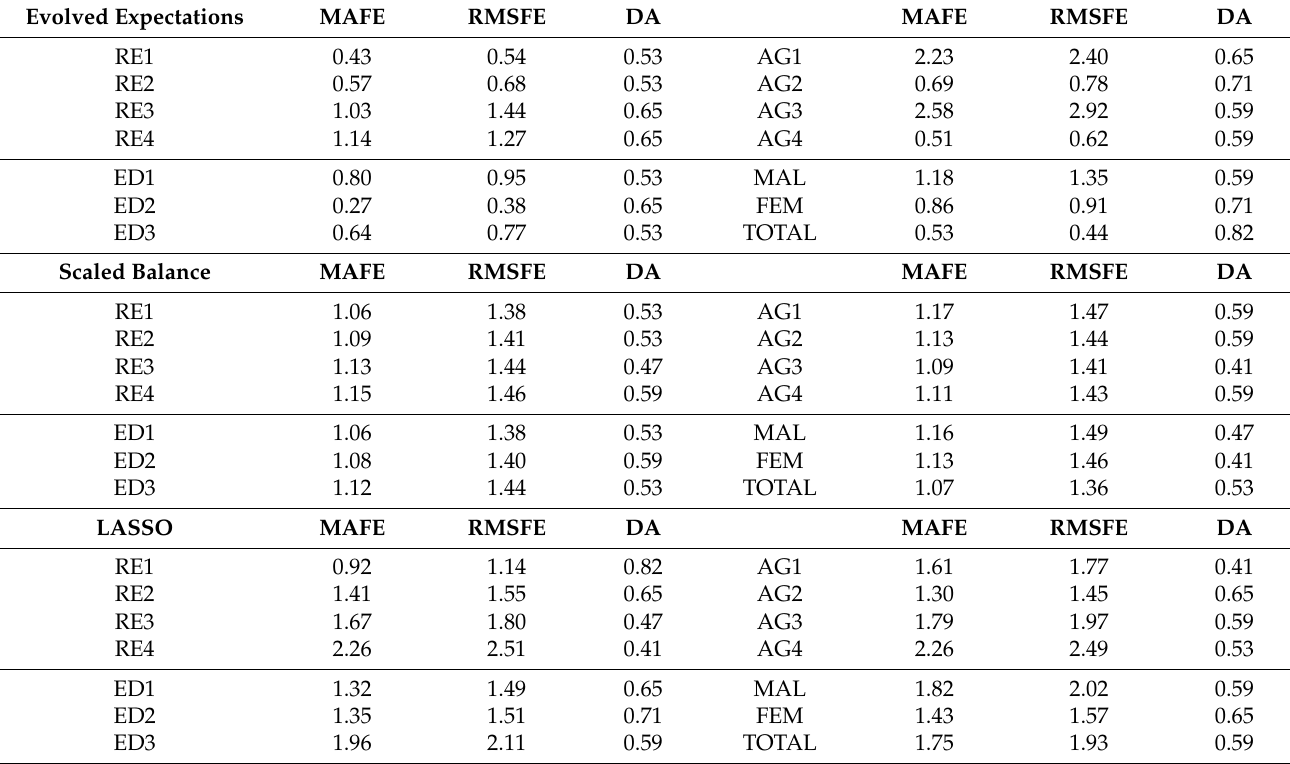
Table 6. Out-of-sample accuracy (2016.Q1–2020.Q2)—unemployment rate nowcasts EA. Evolved